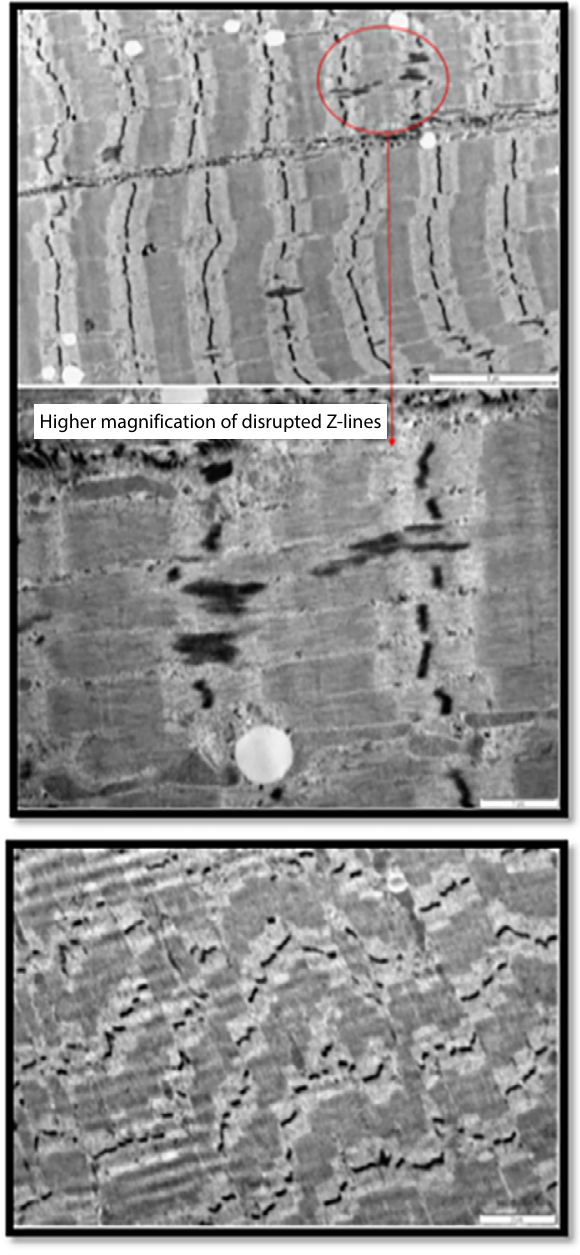
Figure 4: Electron micrographs of m. triceps brachii a). Banding pattern appears mostly normal with a localised area displaying smearing of the Z-lines with smearing of Z-lines seen at a higher magnification. b). Smearing of Z-lines seen at a higher magnification. c). Disruption of Z-lines. (Source of images 4a & 4b, 5: Lizette du Plessis, Electron Microscope Unit, Faculty of Veterinary Science, University of Pretoria)